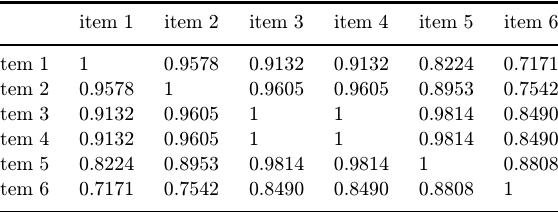
Table 8. Example of an item-to-item similarity